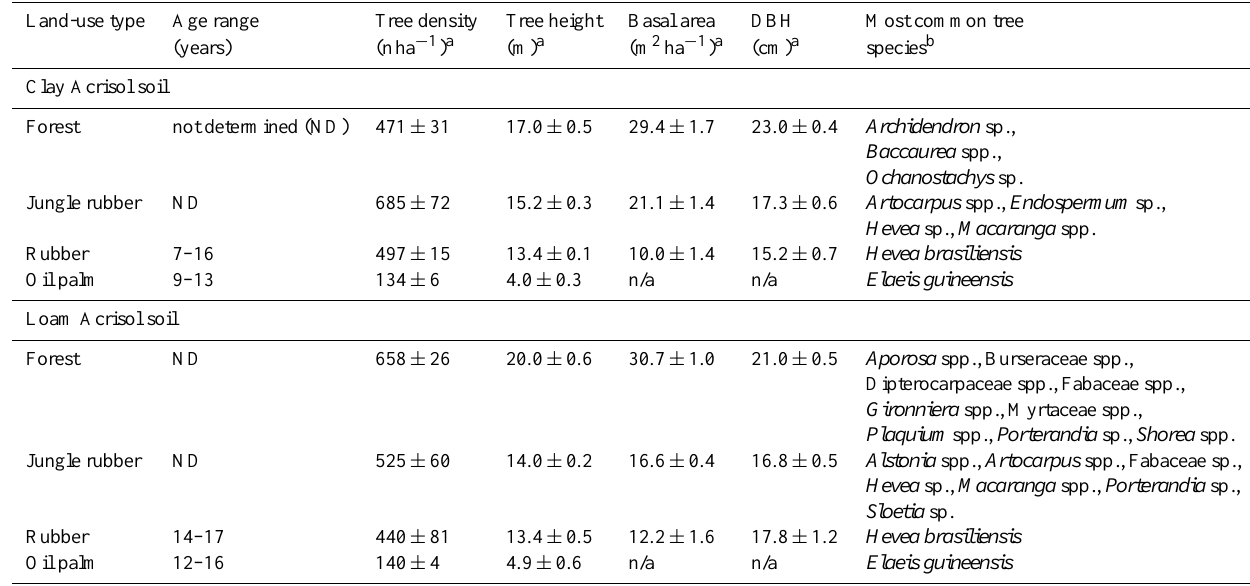
Table A2. Plantation age and mean ( ± SE, n = 4) tree density, tree height, basal area, diameter at breast height (DBH) of trees with ≥ 0 . 10m DBH and the most common tree species for different land-use types within each soil landscape in Jambi, Sumatra,